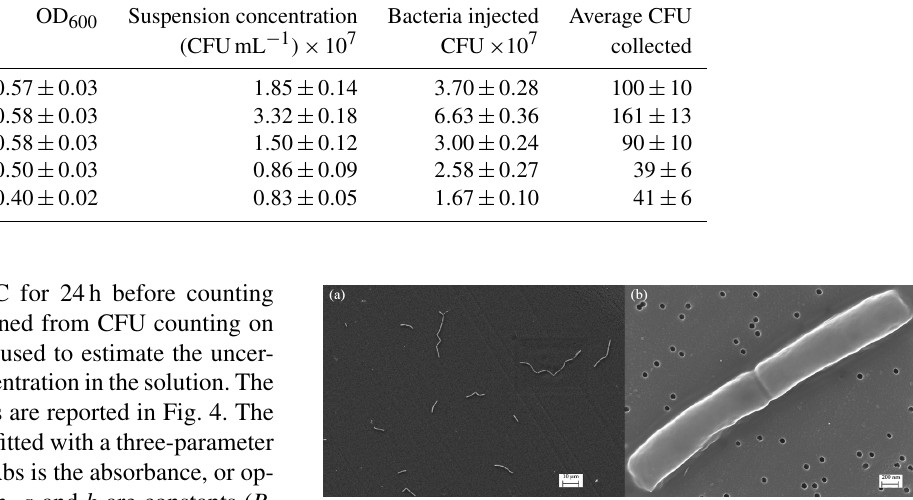
Figure 7. Detail of Bacillus subtilis in physiological solution, mag- nifications 2000 × in panel (a) and 100000 × in panel (b) .